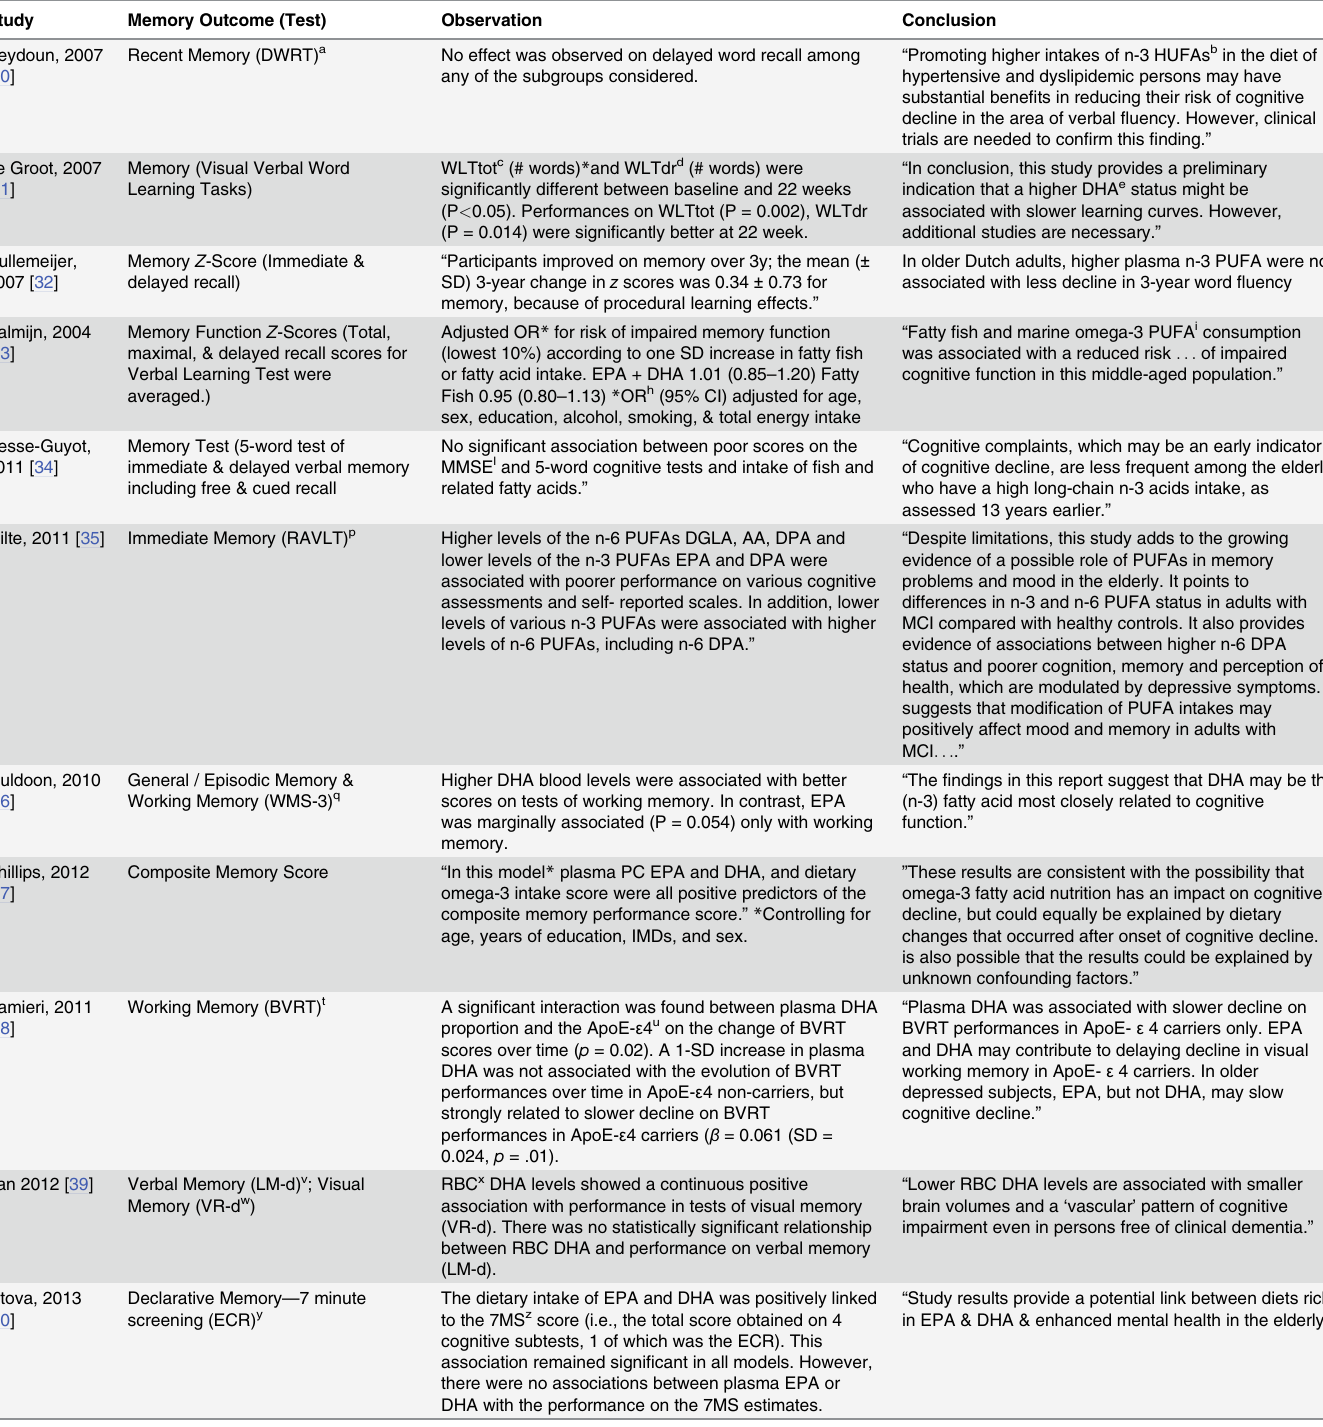
Table 3. Summary of Results from Relevant Observational Studies Regarding DHA/EPA Status and Memory